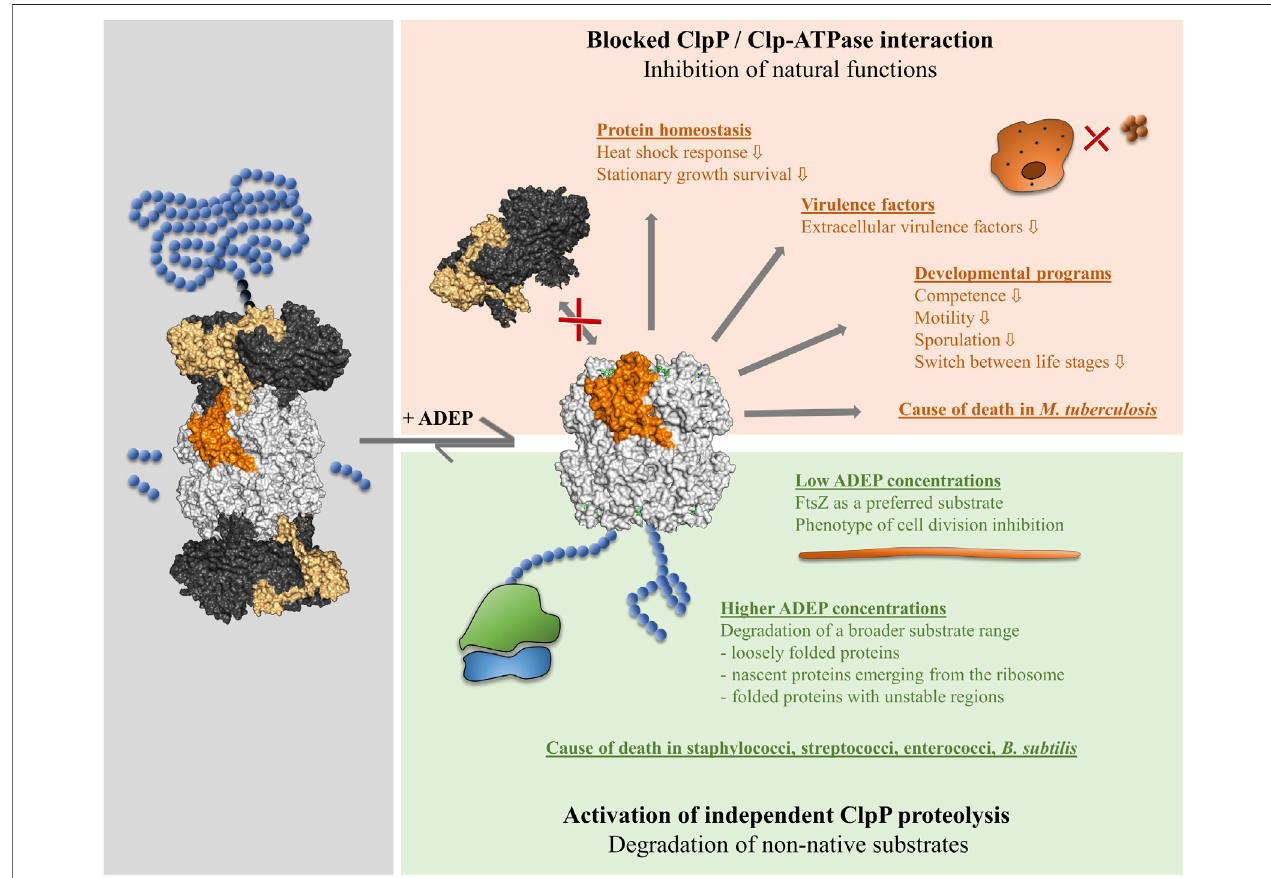
FIGURE 2 | Impact of ADEP on ClpP on the physiological level. ADEP acts by a dual mechanism. The binding of ADEP to the hydrophobic pockets at the apical surface of ClpP causes rapid and ef fi cient displacement of all cooperating Clp-ATPases (red box). Consequently, all the natural functions of the Clp protease in protein homeostasis and regulatory proteolysis are inhibited, of which examples are given. In M. tuberculosis , which depends on a functioning Clp protease for survival, the blockedClp-ATPase/ClpPinteractionisthecauseofdeath.ConformationalcontrolofClpPbyADEPbestowsindependentproteolyticcapabilitiestotheClpPcore (greenbox).Avarietyofnon-nativesubstratesareuntimelydegradedinaconcentration-dependentmanner,ofwhichexamplesaregiven.Theindicatedmembersofthe Firmicutes and other bacterial species die by